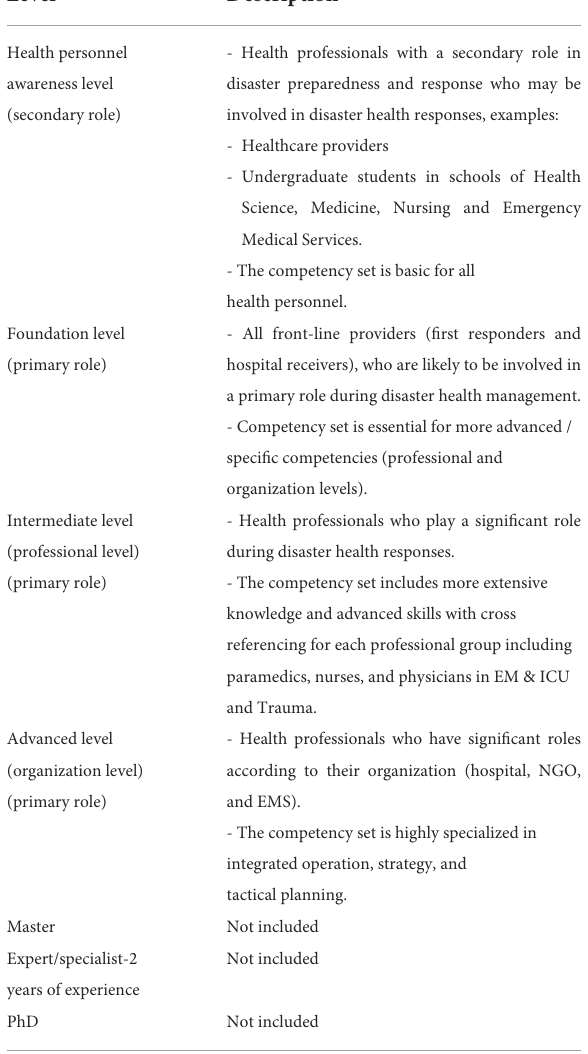
TABLE 1 Criteria for classifying competency sets according to the proposed disaster health education